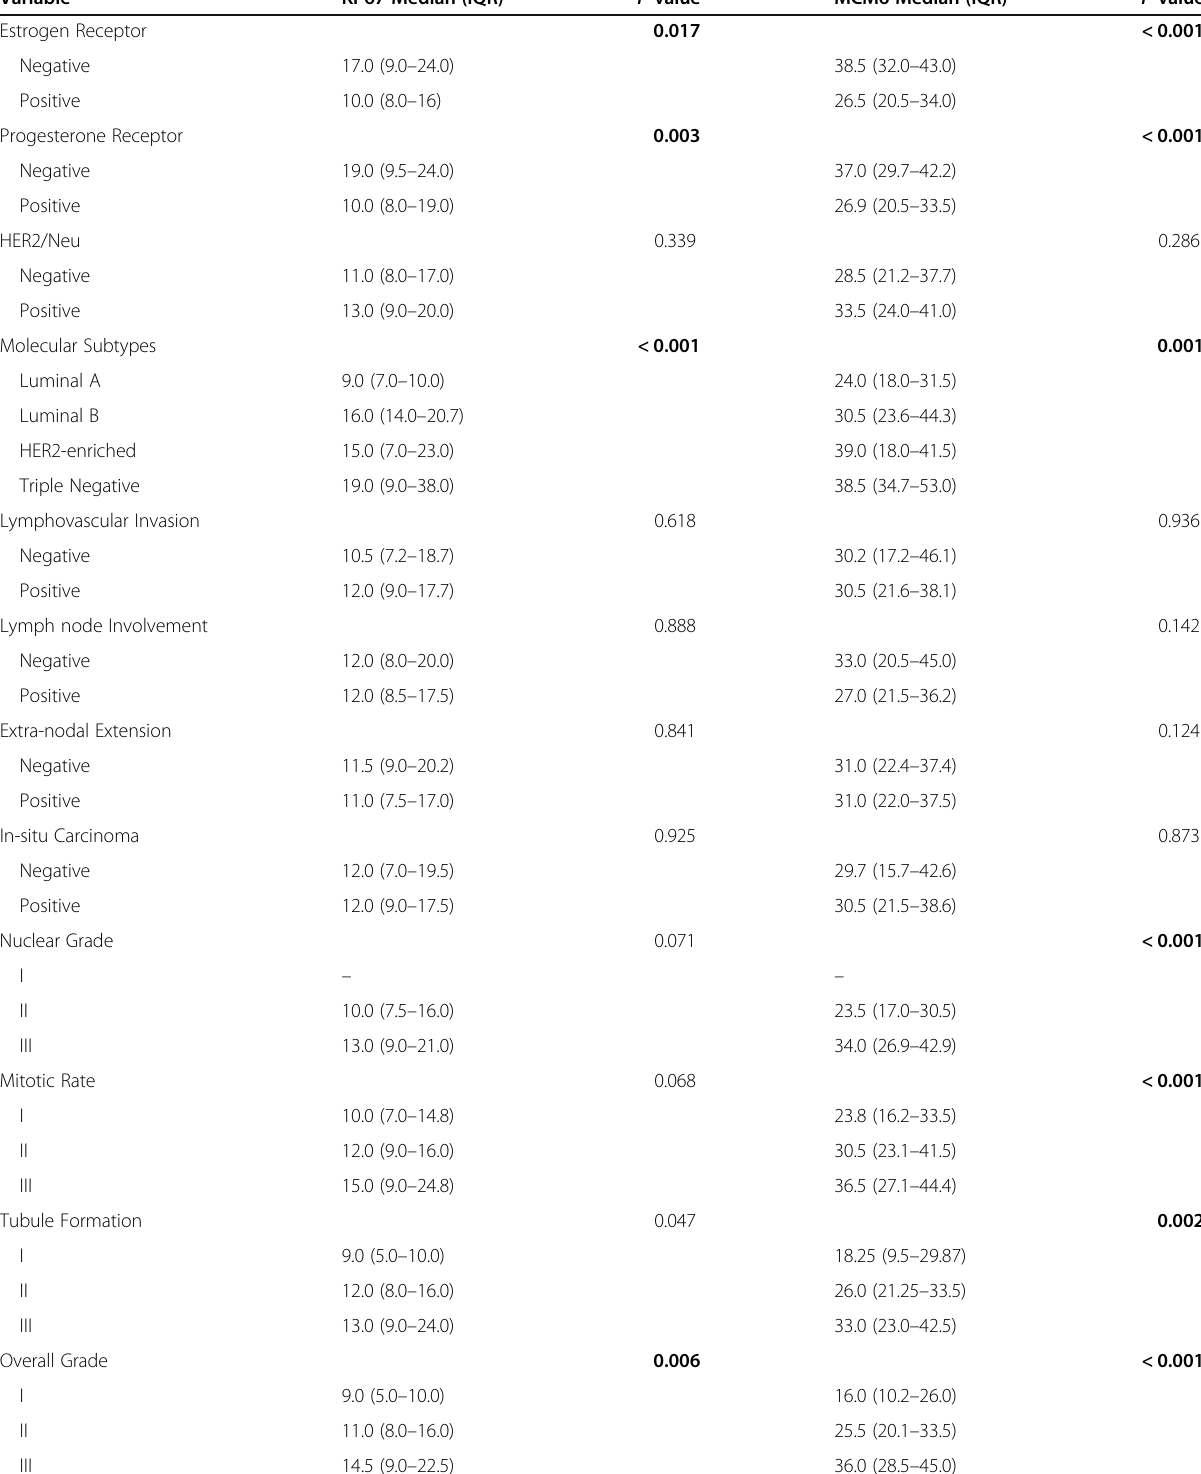
Table 3. Comparison of MCM6 and Ki-67 expression levels based on different histologic and prognostic